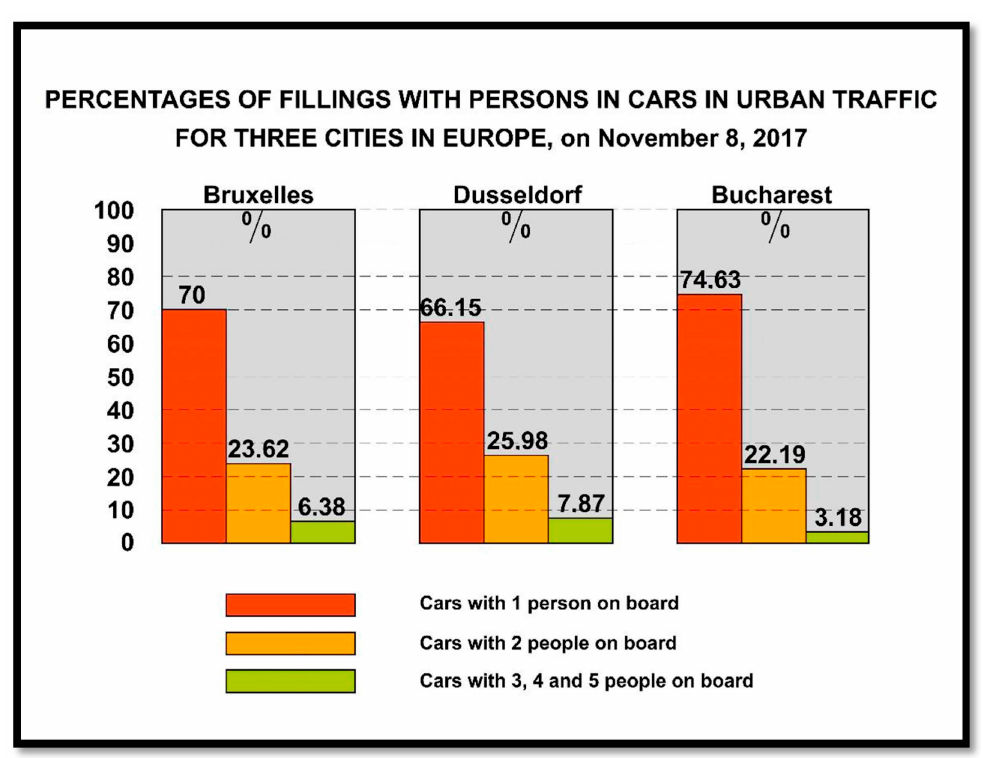
Figure 3. Comparative graph of the occupancy rate of 5-seater cars, in traffic, in three different cities in Europe, on 8 November 2017. Source: authors’ contribution .